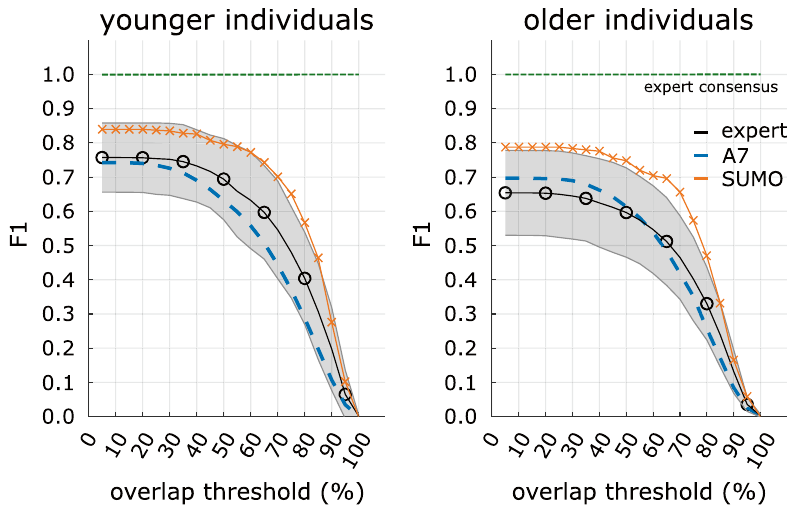
Figure 3. Overlap threshold dependency of F1 scores computed against the expert consensus. The F1 scores of algorithmic (A7: blue dashed line, SUMO: orange crosses) and expert (mean: black circles, standard deviation: gray area) detections decrease monotonically with the overlap threshold for younger (left panel) and older (right panel) individuals. At all thresholds, SUMO shows a higher F1 score compared to A7 as well as most individual experts. SUMO F1 scores were computed on the test set, which we designed to mimic the whole dataset with respect to the A7 performance. Expert and A7 F1 scores were reproduced from Figure 2 in Lacourse et al. 21 , licensed under CC BY 4.0 International 46 . As explained therein, the F1 scores of A7 were computed across the whole dataset, whereas F1 scores for individual experts were computed across the scored subset, and against all remaining experts. For comparison, the green dashed line indicates the expert consensus which serves as the ground